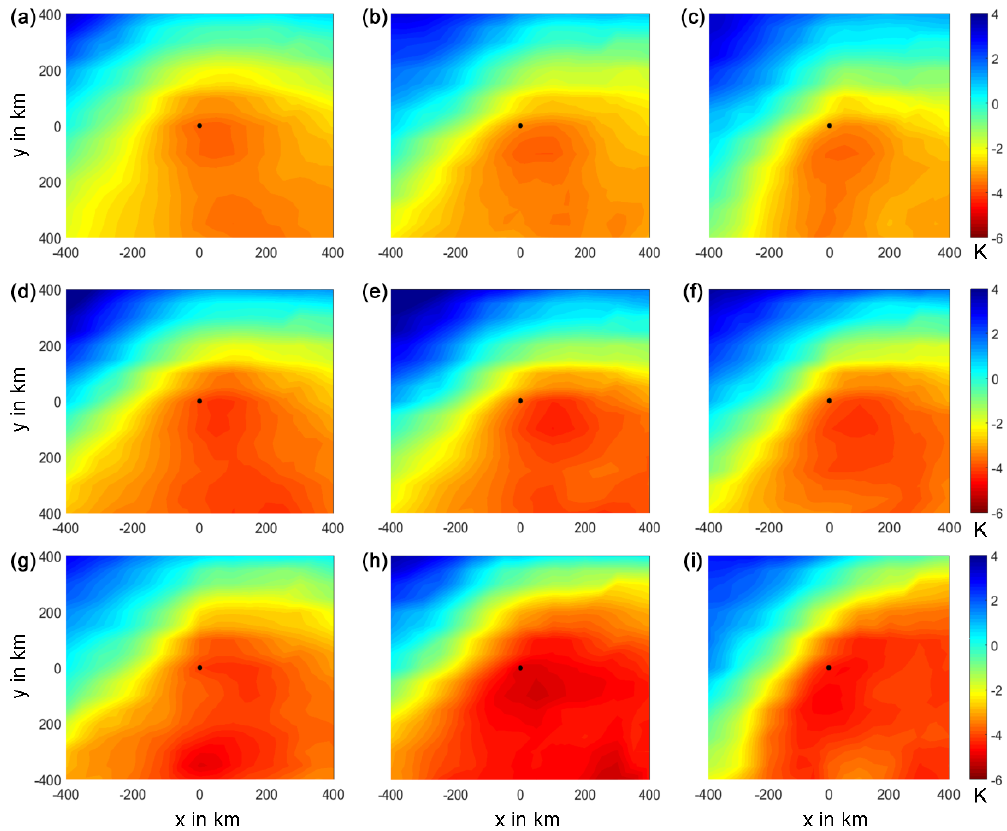
Figure 7. Composite analyses of SLI related to maximum observed hail diameters of D < 3cm (a–c) , 3–4.5cm (d–f) , and ≥ 5cm (g–i) and for track lengths of L < 50km (a, d, g) , 50–100km (b, e, h) , and ≥ 100km (c, f, i) . The sizes of the subsamples are listed in Table